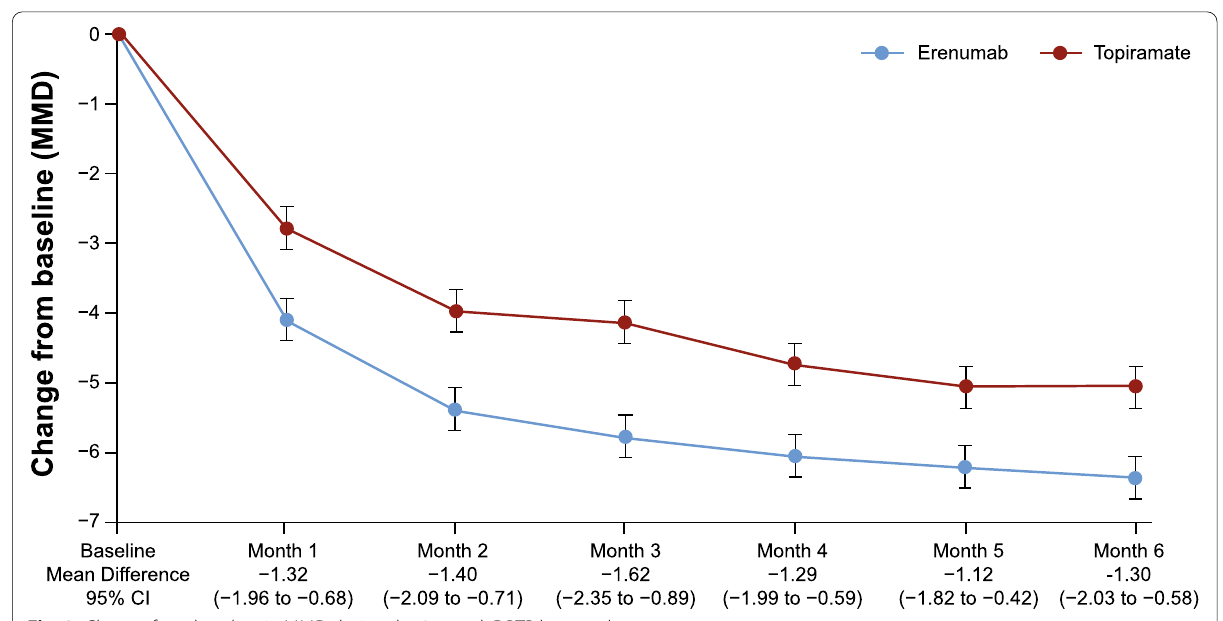
Fig. 3 Change from baseline in MMD during the 24‑week DBTP by